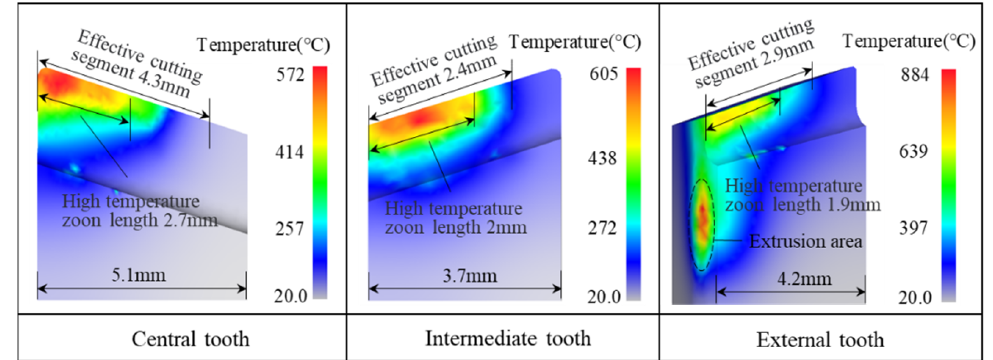
Figure 6. Temperature field on each cutter tooth for ordinary drilling.